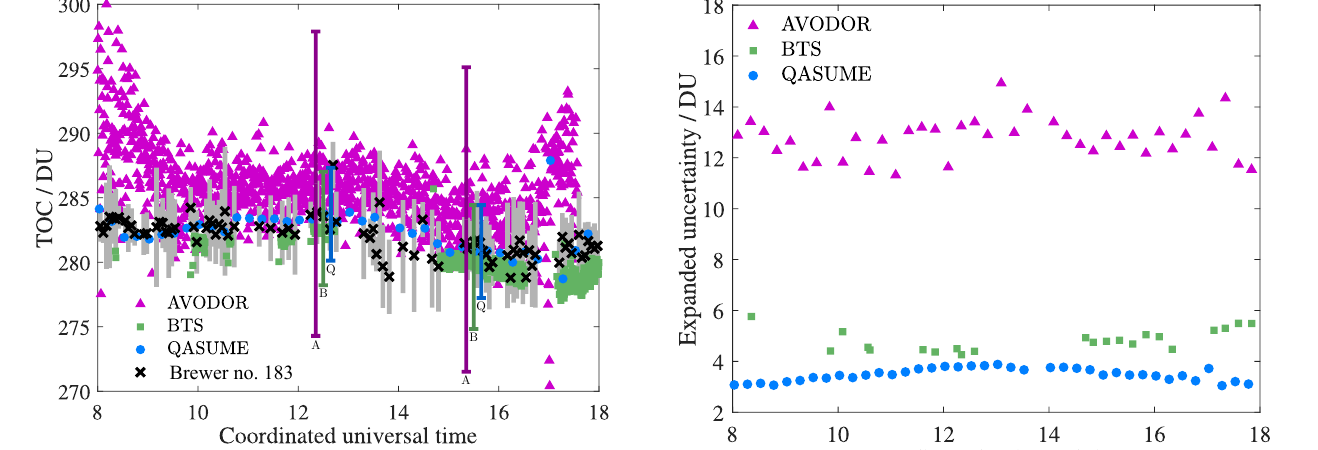
Figure 7. Expanded uncertainties in the total ozone columns de- rived from QASUME, BTS, and AVODOR spectra obtained by the relative least squares fitting